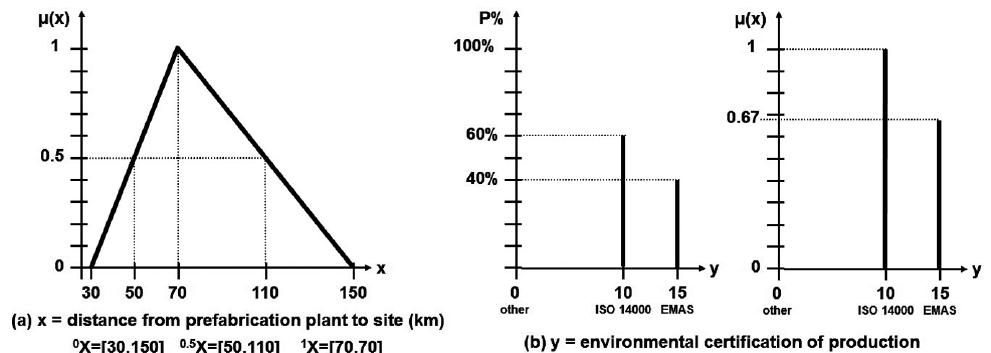
Fig. 2. Examle of fuzzy